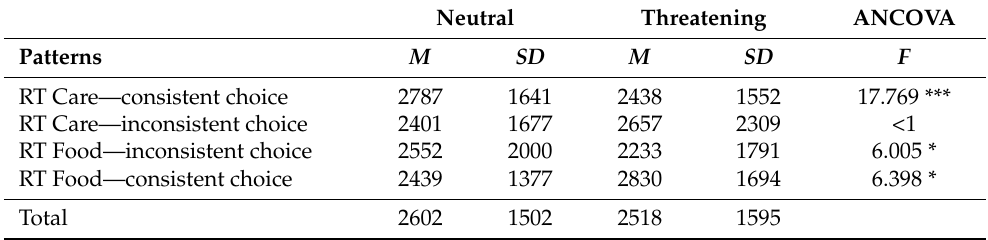
Table 4. RT (ms) means of the four consistency choice patterns under neutral and threatening conditions. Neutral Threatening